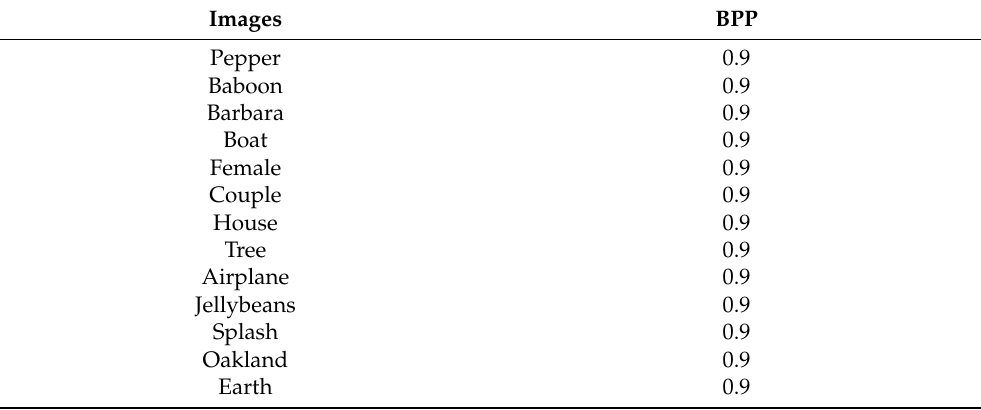
Table 3. Capacity for the standard dataset images.